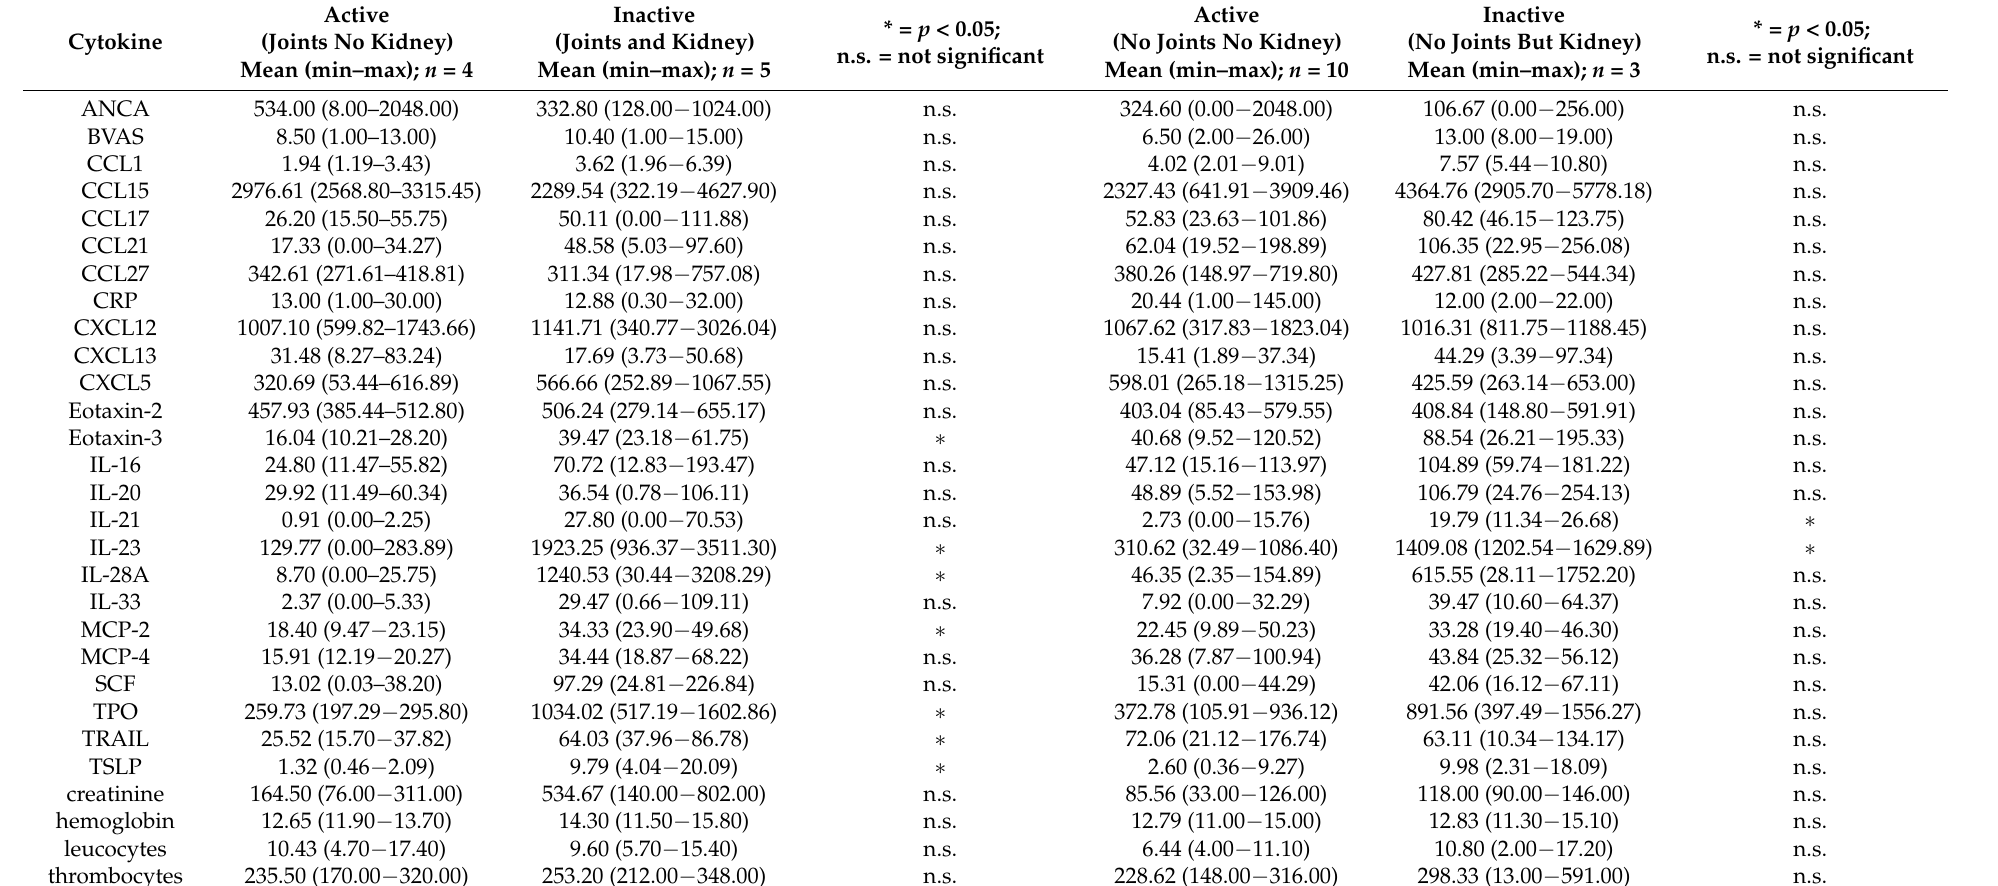
Table 5. (left) Cytokines, laboratory parameter, PR3-ANCA titer, and BVAS at active AAV with joint involvement differentiated into patients with and without kidney involvement. (right) Cytokines, laboratory parameter, PR3-ANCA titer, and BVAS at active AAV with no joint involvement differentiated into patients with and without kidney